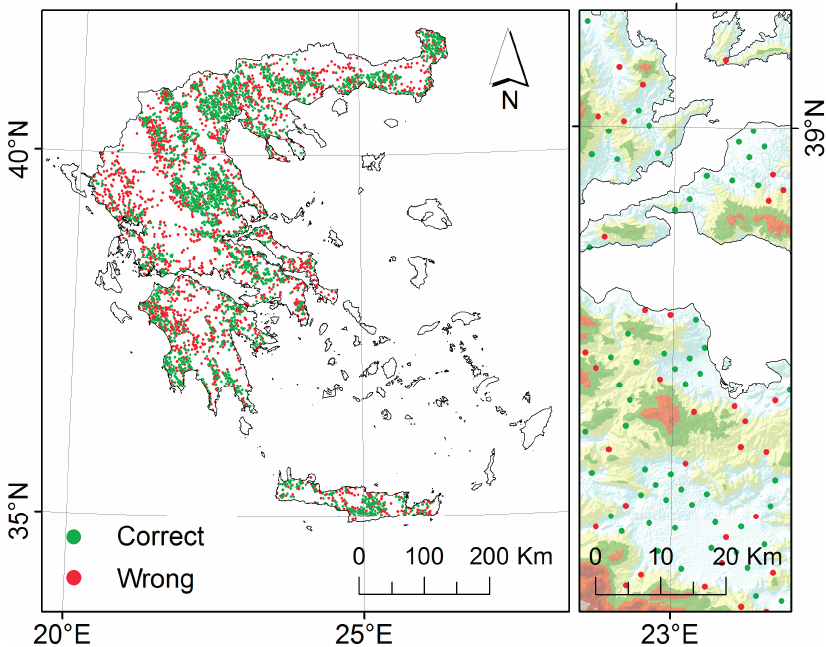
Figure 5. Spatial distribution of classification errors for the class “Agricultural land” of the WWF Hellas map; in the inset, a closer view from central Greece, on an elevation background.